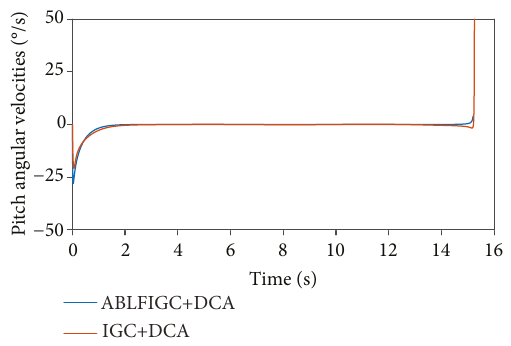
Figure 4: Attack angle curves of the interceptor missile in Scenario 1: ABLFIGC+DCA refers to a combination of the proposed asymmetric barrier Lyapunov function-based IGC algorithm and the dynamic control allocation algorithm; IGC+DCA refers to a combination of the IGC algorithm subject to the traditional dynamic surface sliding-mode control law and the dynamic control allocation